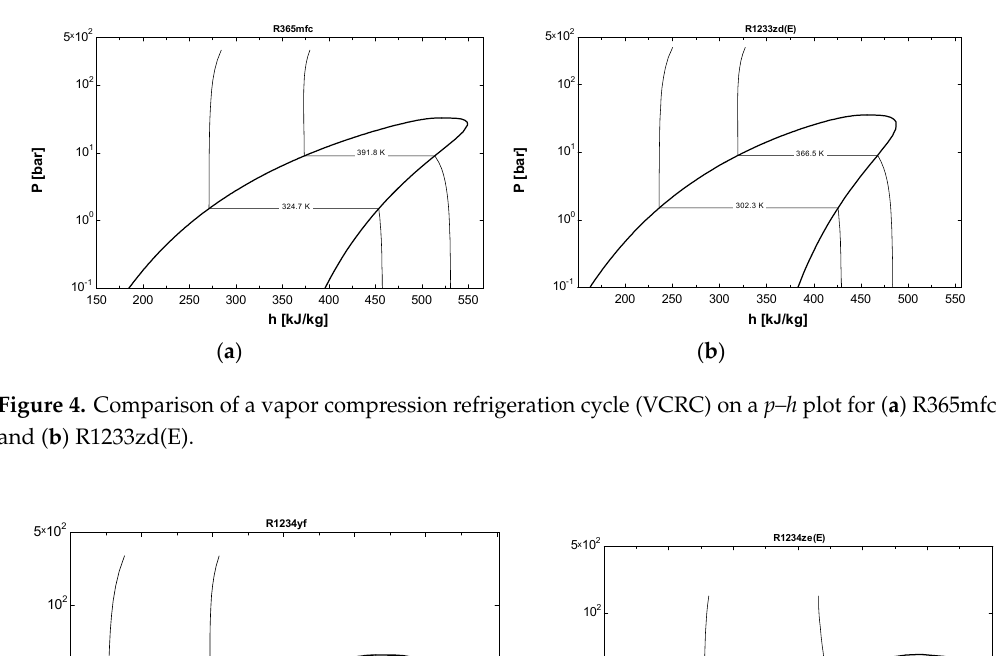
Figure 4. Comparison of a vapor compression refrigeration cycle (VCRC) on a p–h plot for ( a ) R365mfc and ( b ) R1233zd(E).